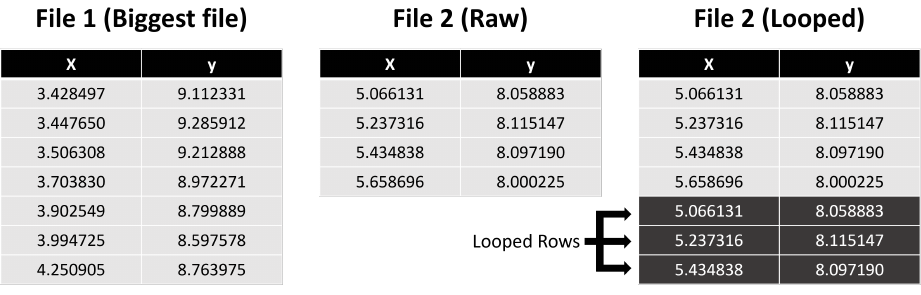
Figure 2. Looped rows example.